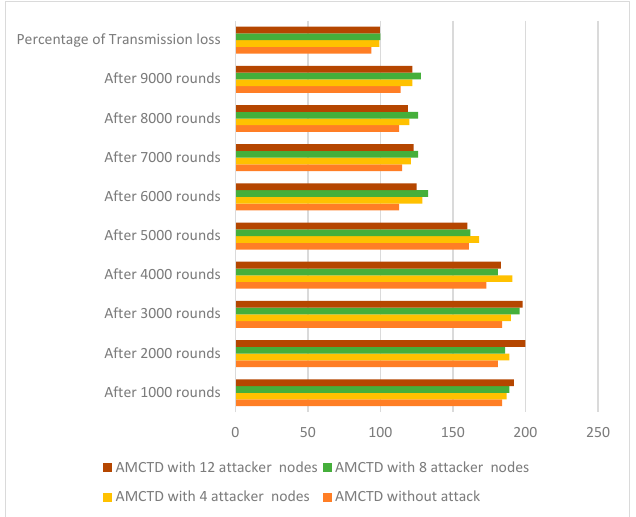
Figure 7. Transmission loss of AMCTD without Attack, AMCTD with 4, 8 and 12 Attacker Nodes.